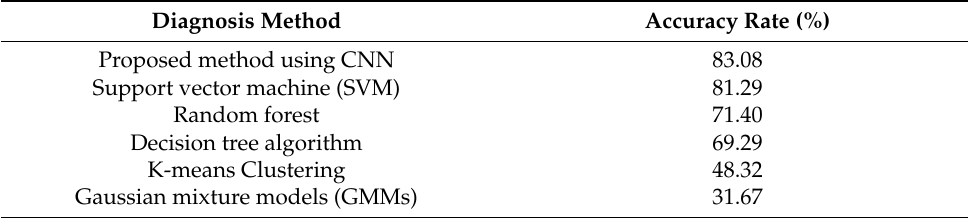
Table 2. Comparison of diagnosis